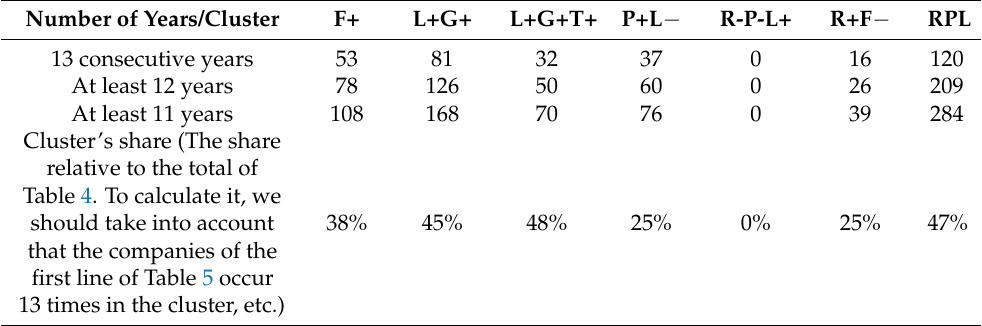
Table 4. To calculate it, we